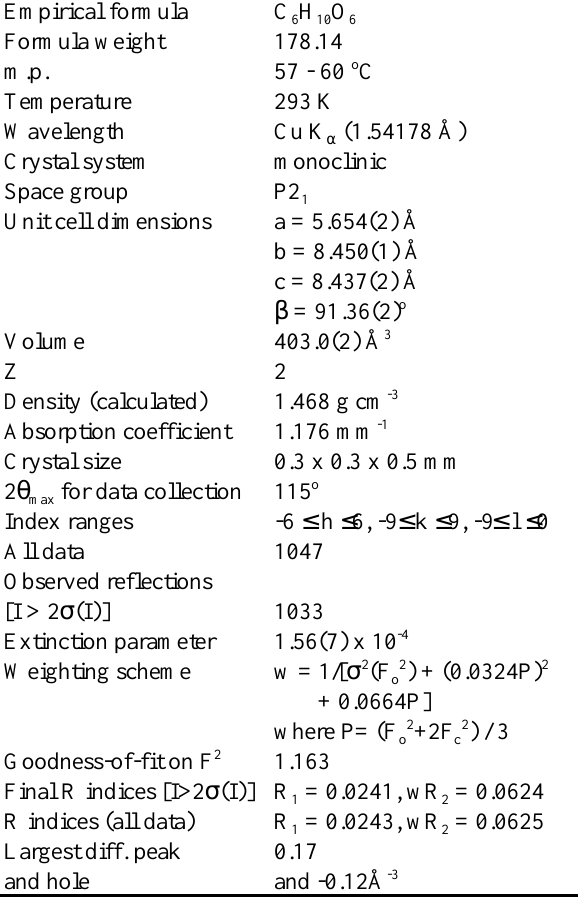
Table 1. Crystal data for dimethyl (R,R)-(+)-tartrate. Table 2. Atomic coordinates (x 10 4 ) and equivalent iso-